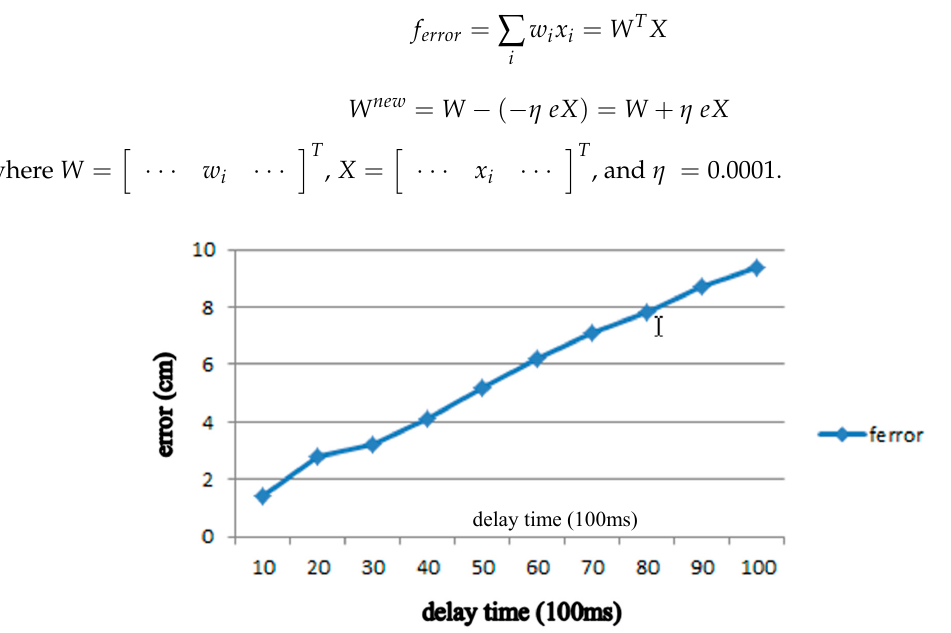
Figure 10. f error Figure 10. error f curve.